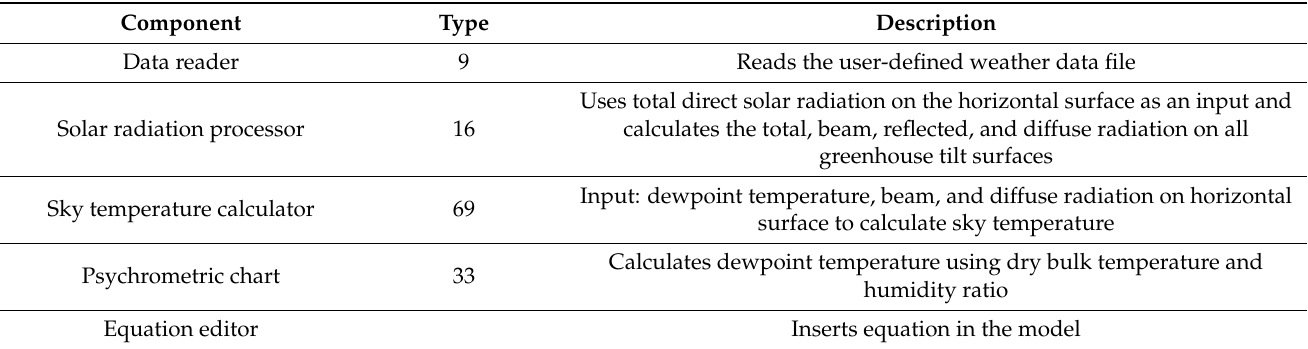
Figure 6. TRNSYS simulation studio showing proposed model’s components for air-to-water heat pump system integrated with multi-span greenhouse. Yellow box: heat pump, green box: storage tank, black box: fan coil units, purple box: multi-span experimental greenhouse modeling, TRNBuild, red box: weather data reading and processing. Table 3. Components of the greenhouse model in TRNSYS